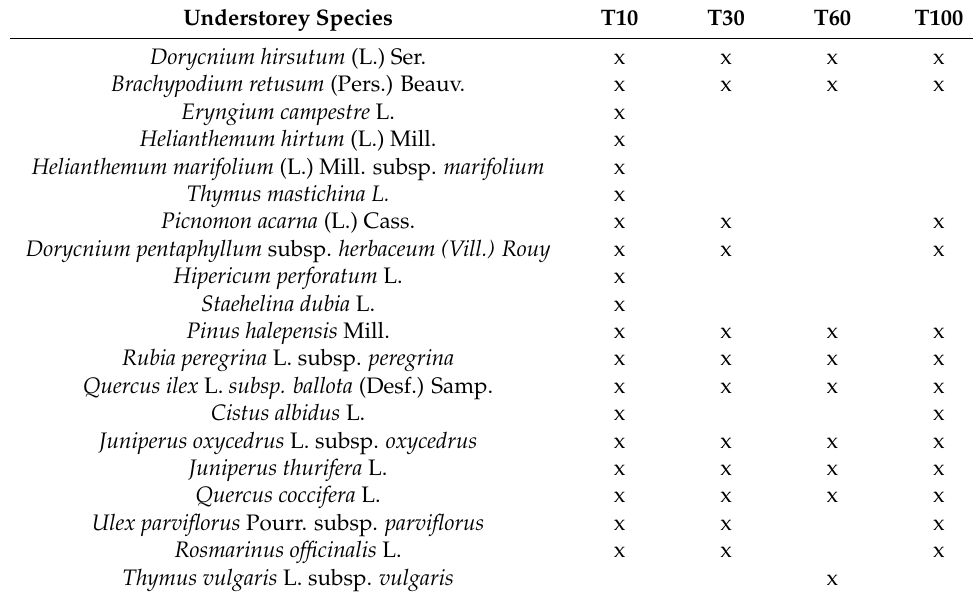
Table A2. Observed understorey species in the tested treatments. Data were taken in June 2020, where four systematic 20 m length transects were considered for each experimental